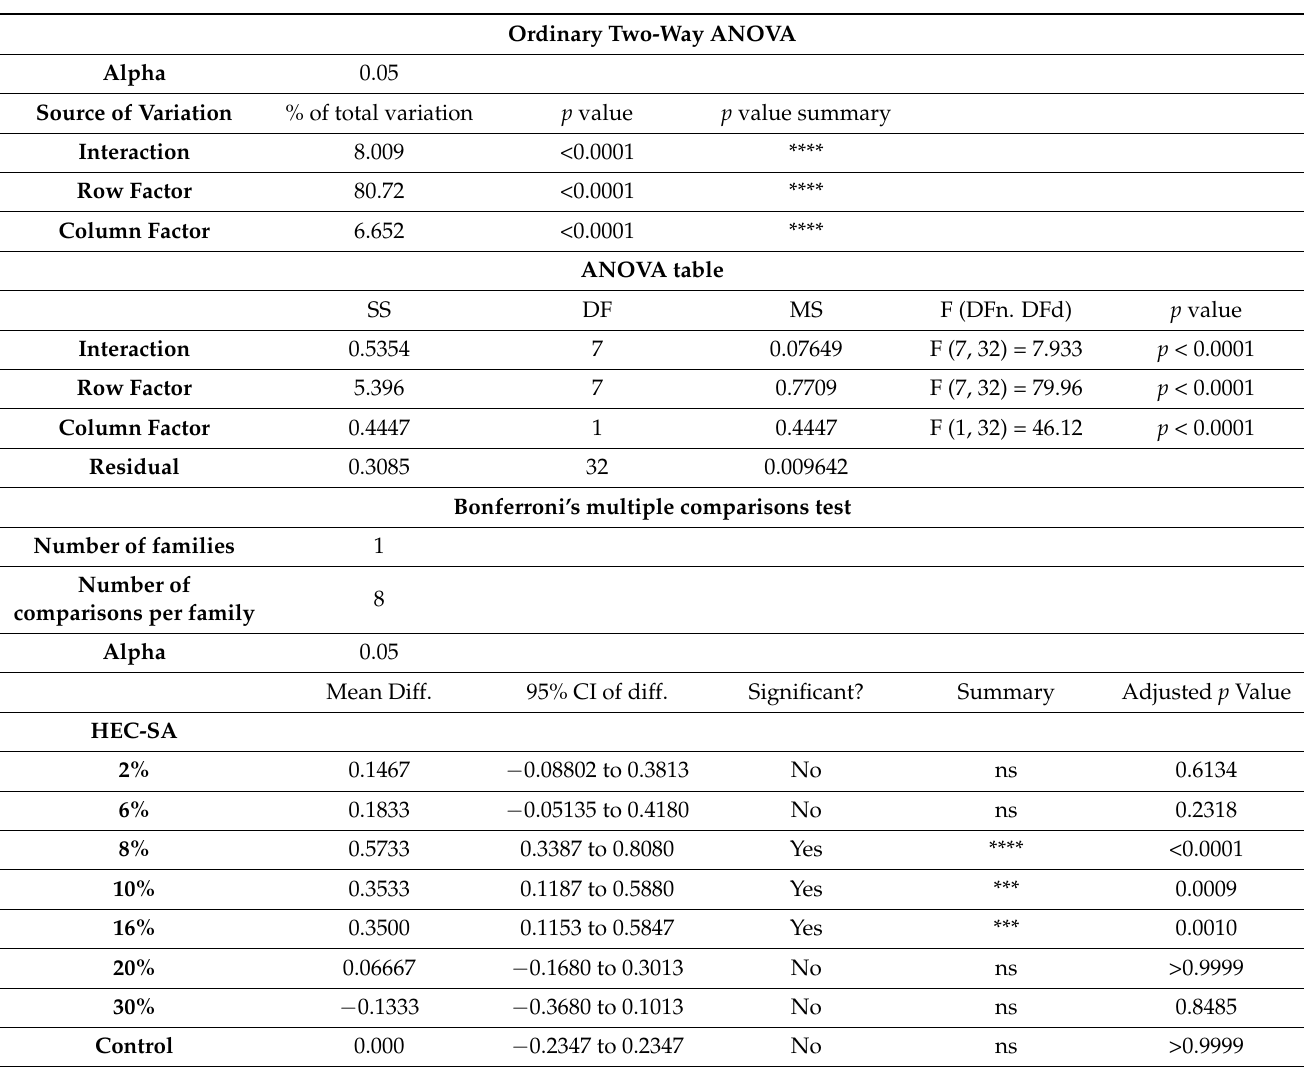
Table A2. Ordinary two-way oviposition ANOVA analysis of HEC2-30 and SA2-30 concentra- tions and Bonferroni’s multiple comparisons test. p > 0.0123 = not significant (ns); p < 0.0002 ***; p < 0.0001 = ****.